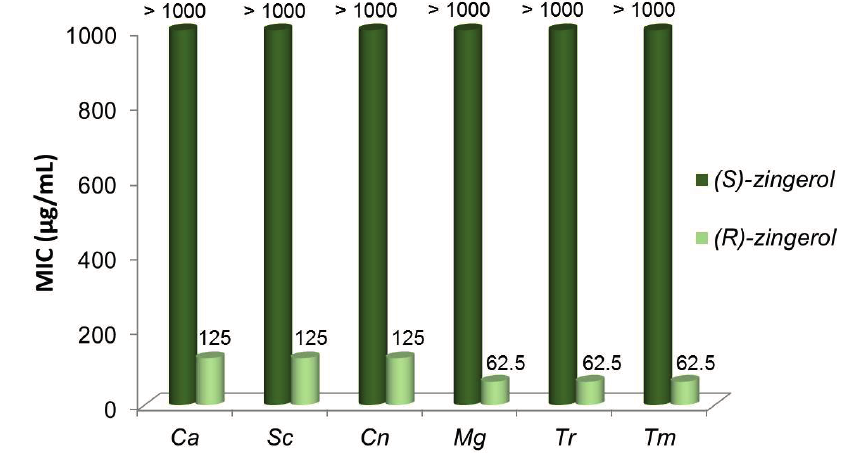
6. Comparative antifungal activities of ( S )- (94% ee ) and ( R )-zingerol (98% ee ) against yeasts and filamentous fungi. Ca : Candida albicans ATCC 10231; Sc : Saccharomyces cerevisiae ATCC 9763; Cn : Cryptococcus neoformans ATCC 32264; Mg : CCC 110; Tm : Trichophyton mentagrophytes ATCC 9972. MICs of terbinafine against Mg , Tr and Tm = 0.04, 0.01 and 0.04 µg/mL, respectively. MICs of Amphotericin B against Ca , Sc and Cn = 1.00, 0.50 and 0.25 µg/mL,